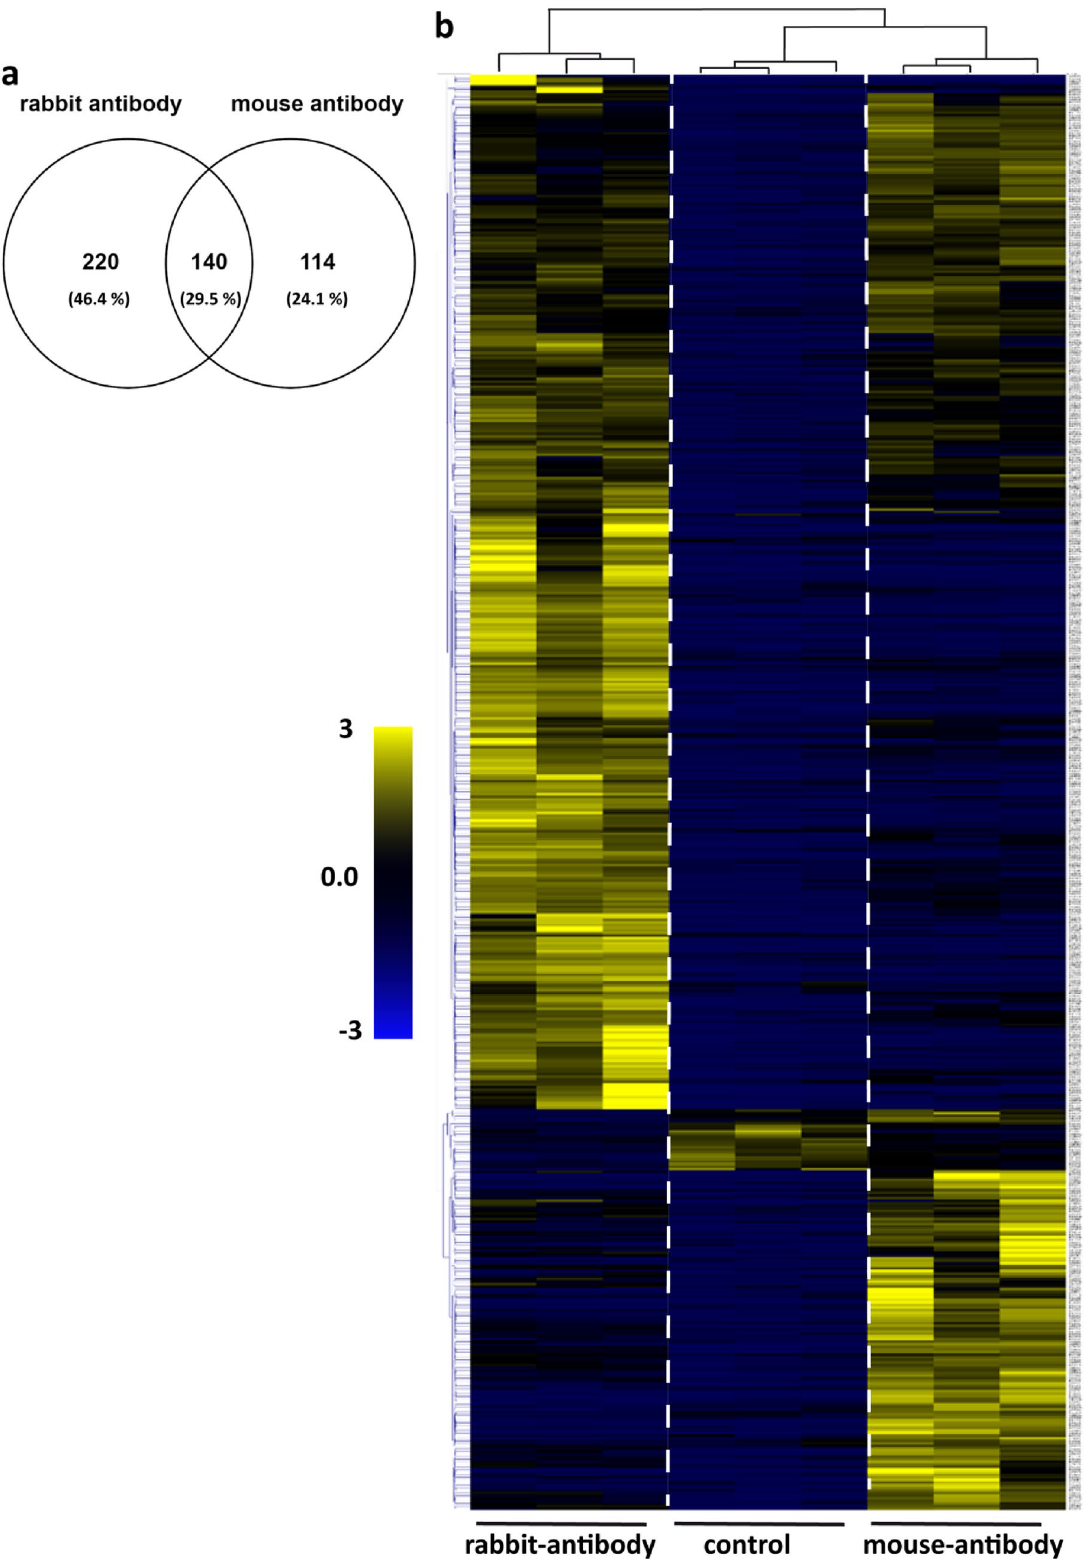
Figure 2. ( a ) Venn diagram showing the number of proteins purified respectively with the rabbit and the mouse antibodies. ( b ) Unsupervised hierarchical clustering and heatmap overview showing the protein abundance patterns using the two different antibodies (Multiple Experiment Viewer software, version